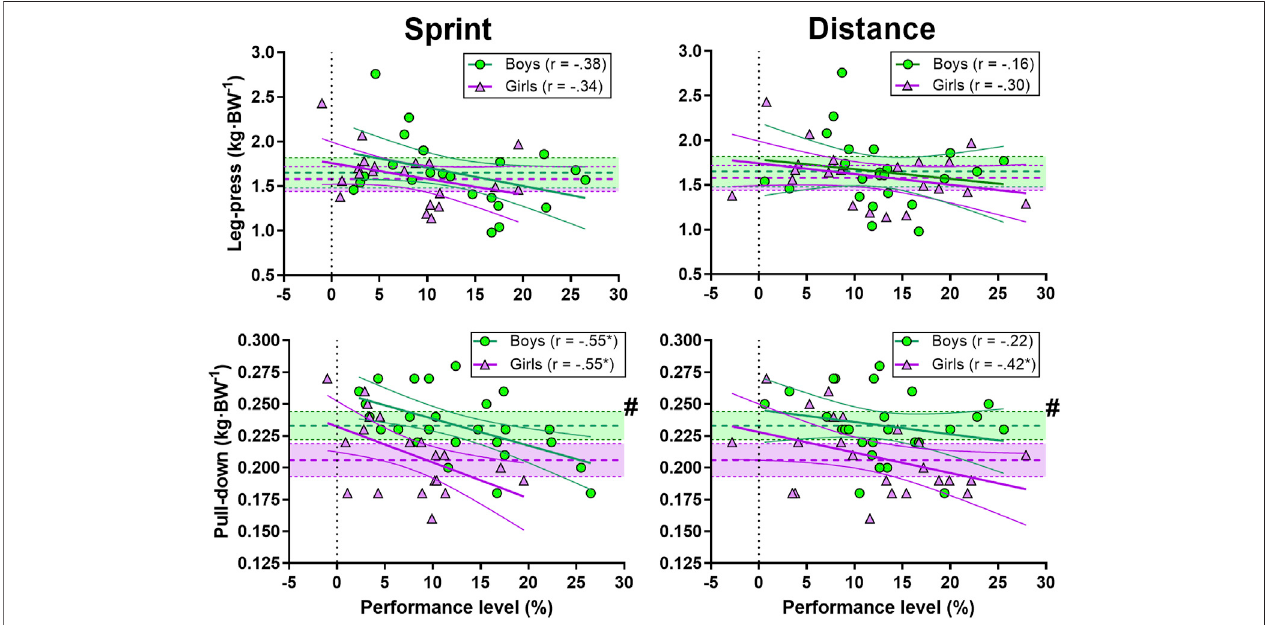
FIGURE 7 | Correlation between sprint (left panel) and distance performance (right panel) and leg-press (upper panel) and pull-down (lower panel) strength. Green circles represent individual values for the boys. Purple triangles represent individual values for the girls. Shaded areas with dotted lines in the middle represent mean ±95%con fi denceinterval(CI)(greenareafortheboysandpurpleforthegirls).Thickandnarrowlinesrepresentthebest fi tregressionlineandthe95%con fi dencebands (green lines for the boys and purple for the girls). See the method section for an explanation of the performance level. * Correlation is signi fi cant at the 0.05 level. # signi fi cant difference between boys and